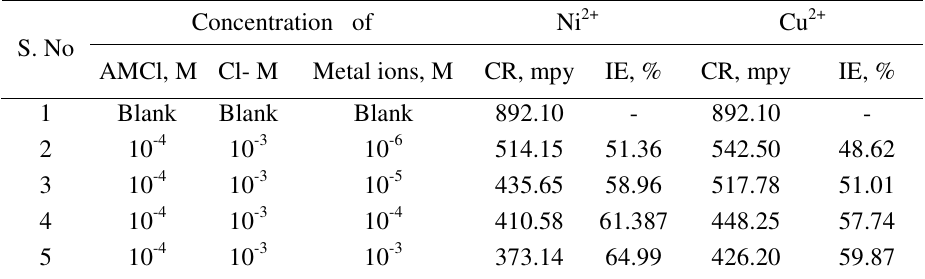
SO (5 h study) 2 4